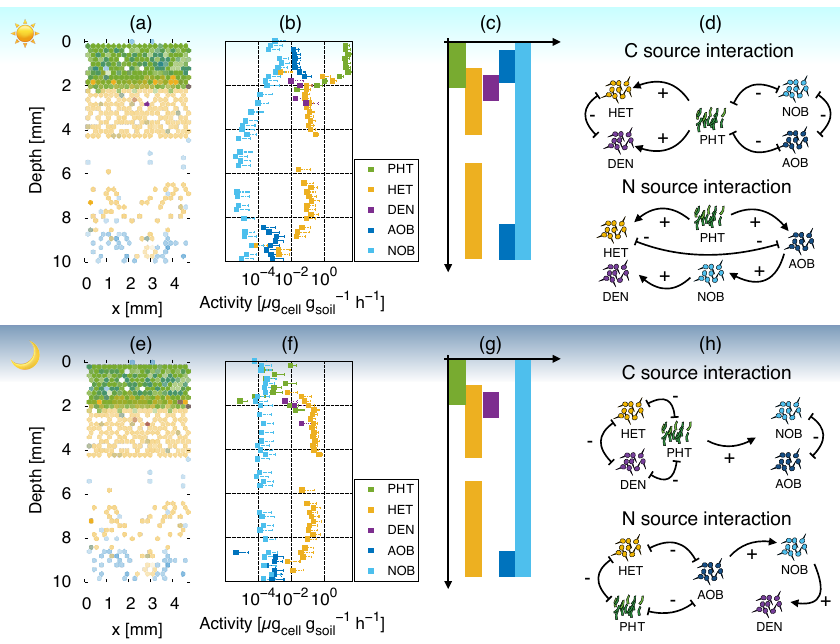
Figure 6. Diurnal shifts in microbial activity and spatial distributions in desert biocrusts. A typical result of simulated biological activity profiles within wet biocrusts at midday (top panel) and at midnight (bottom panel) at field capacity. Local microbial activity is expressed in µg cell g − 1 h − 1 (product of local biomass and growth rate per gram of soil). (a, e) Spatial distribution of microbial activity is given. Five soil colours (green, yellow, purple, dark blue, and light blue) represent the microbial groups (photoautotrophs (PHT), aerobic heterotrophs (HET), anaerobic heterotrophs (DEN), ammonia oxidisers (AOB), and nitrite oxidisers (NOB), respectively). Higher activity is shown with stronger colours. Vertical distribution of microbial activity at midday (b) and at midnight (f) . Local activities are averaged (only with patches where the activity occurs) with respect to the horizontal direction. Only upper SDs ( + 1SD) are shown considering the log scale plot. (c, g) The spatial extent of the activity of each functional microbial group within the biocrust is represented by a bar (of the assigned colours above). (d, h) Phototrophic activity changes during the day and night, resulting in distinctive trophic interaction patterns over carbon and nitrogen sources; ( + ) and ( − ) indicate mutualistic and competitive interactions,